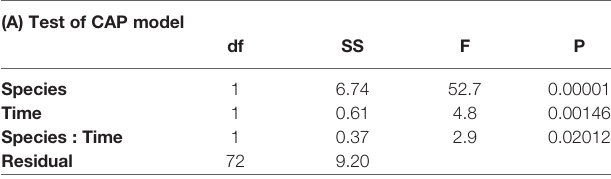
TABLE 2 | Canonical analysis of principal coordinates (CAP) of the effects of species ( Schiedea kaalae or S. hookeri ) and time of day on fl oral scent composition. (A) ANOVA-like permutation test ( n = 99999 iterations) of each term. (B) Compound scores on the fi rst CAP axis, which discriminated between the species. Absolute scores ≥ 0.02 are included. Negative values indicate compounds associated with S. hookeri , and positive values indicate compounds associated with S. kaalae